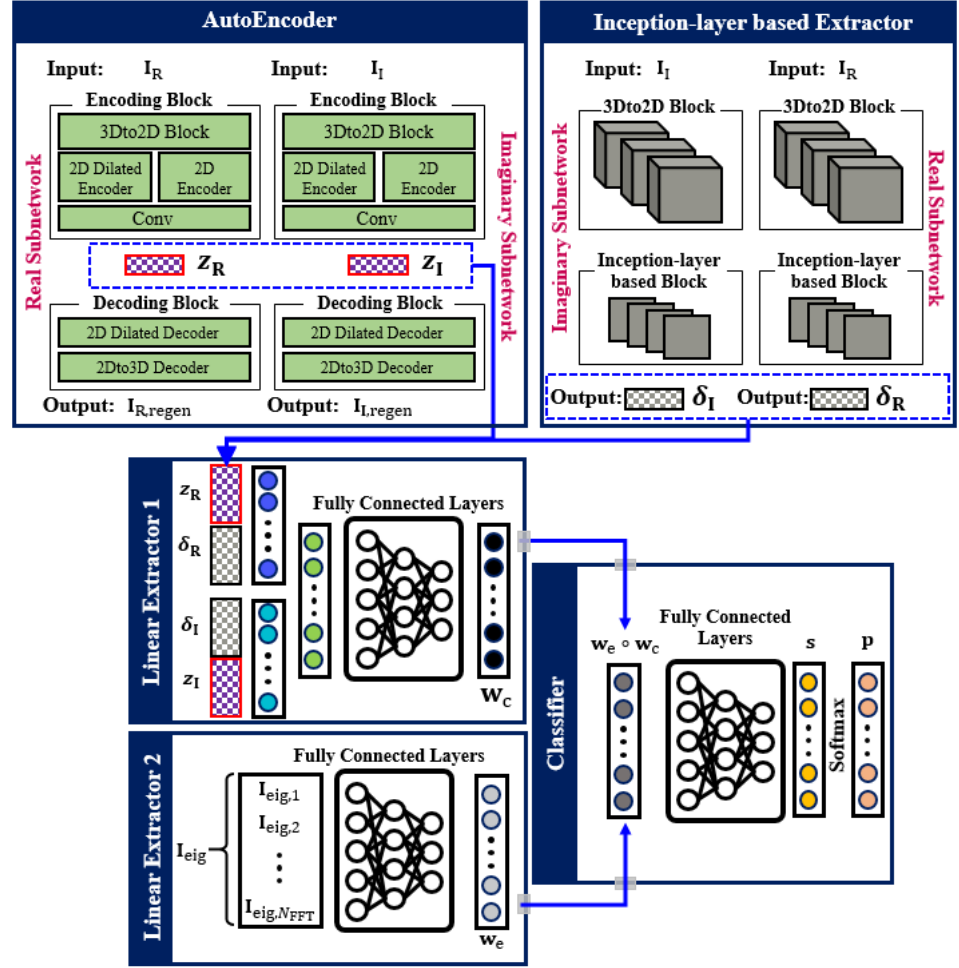
Figure 6. Asynchronous stream-sensing network (ASensNet)